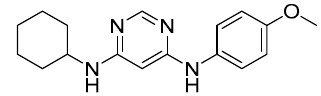
Figure 1. Structure of the cardiomyogenesis-inducing agent VUT-MK142.